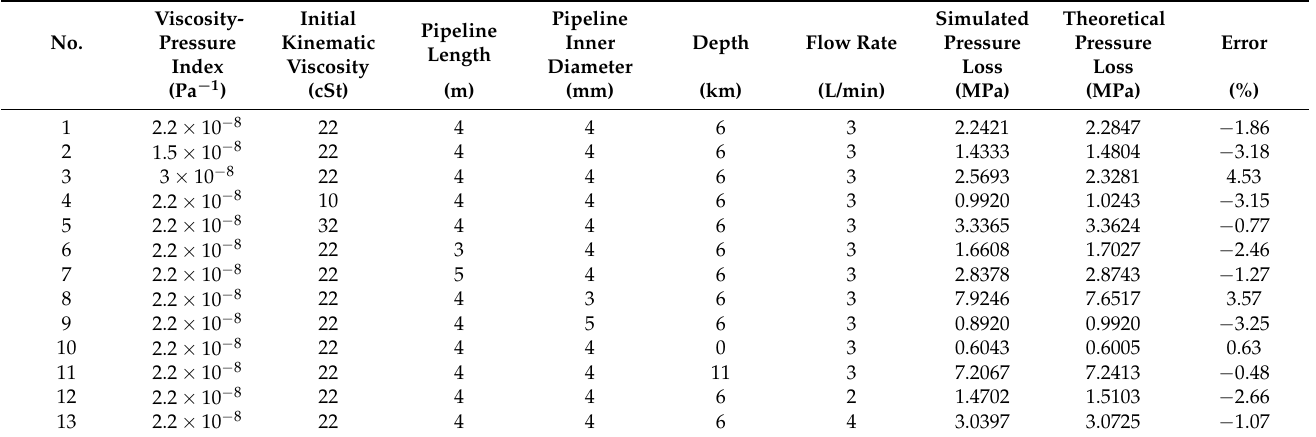
Table 1. Pressure